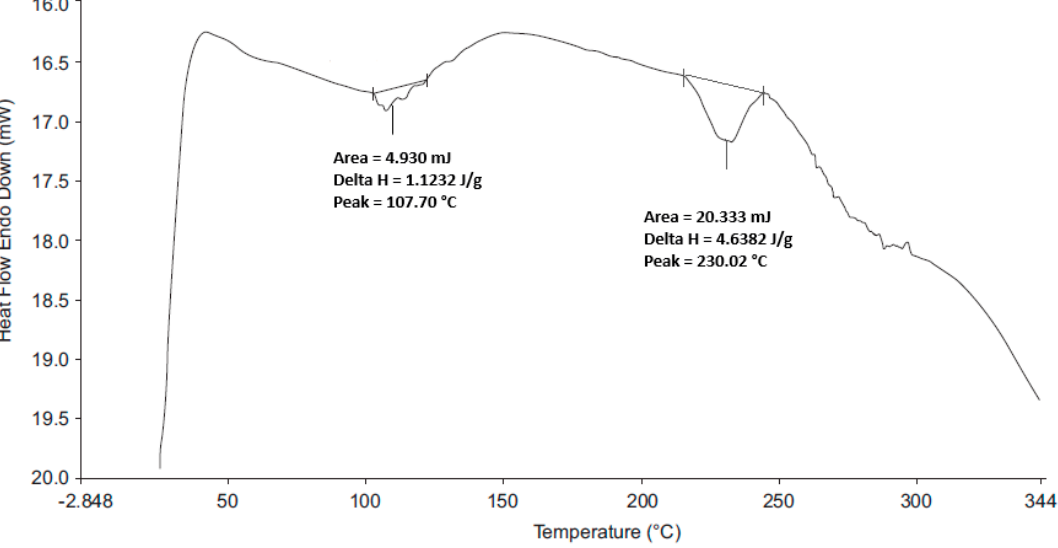
Figure 10. DSC thermogram of optimised CPT microparticles.